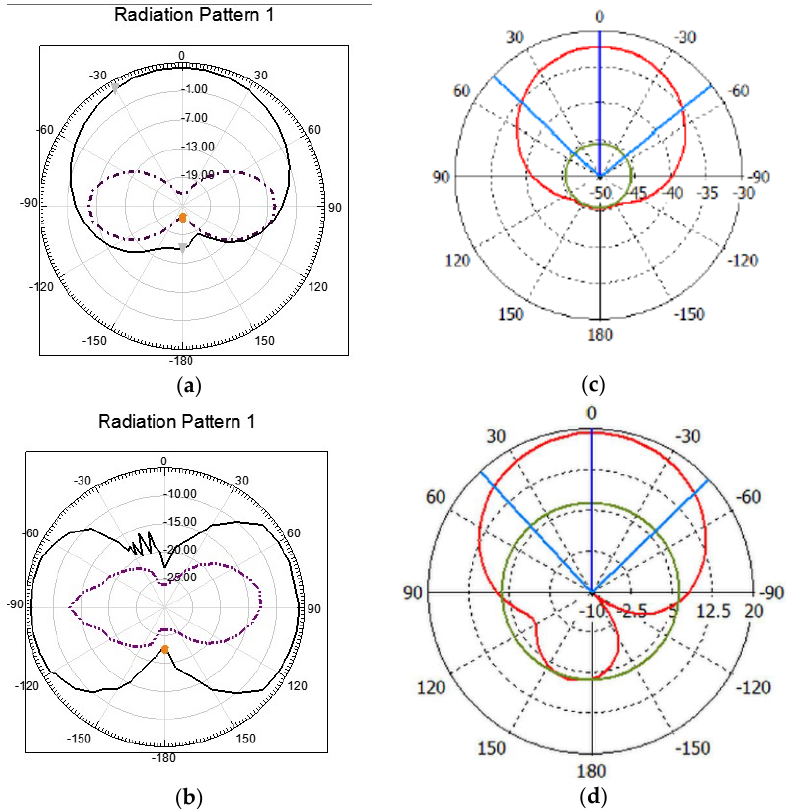
Figure 10. ( a ) Far-field radiation pattern radiating at 3.6 GHz (H-plane—solid line, E-plane—dotted line); ( b ) far-field radiation pattern radiating at 5.8 GHz (H-plane—solid line, E-plane—dotted line). ( c ) Radiation pattern of second iterations (E-plane, with DGS) at 2.48 GHz. ( d ) Radiation pattern of second iterations (H-plane, with DGS) at 2.48 GHz.